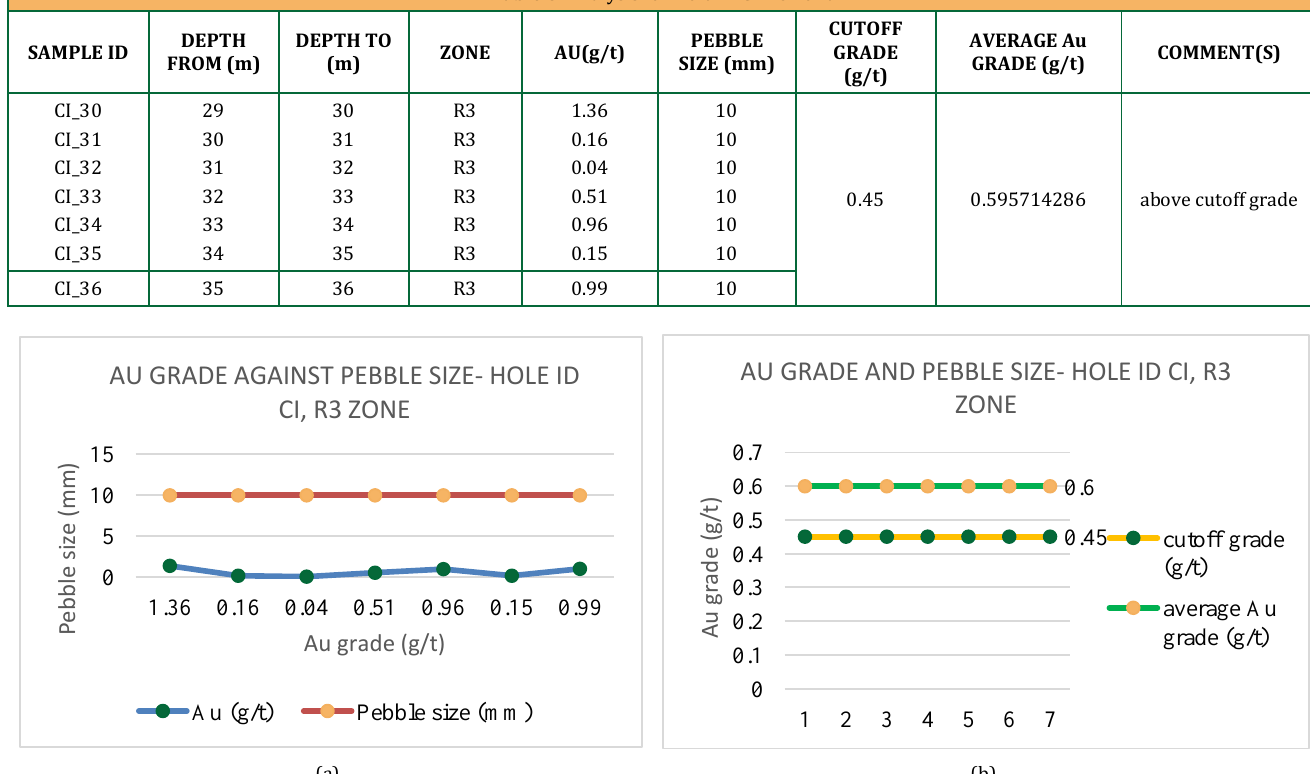
Table 5: Analysis for Hole ID CI-R3 zone